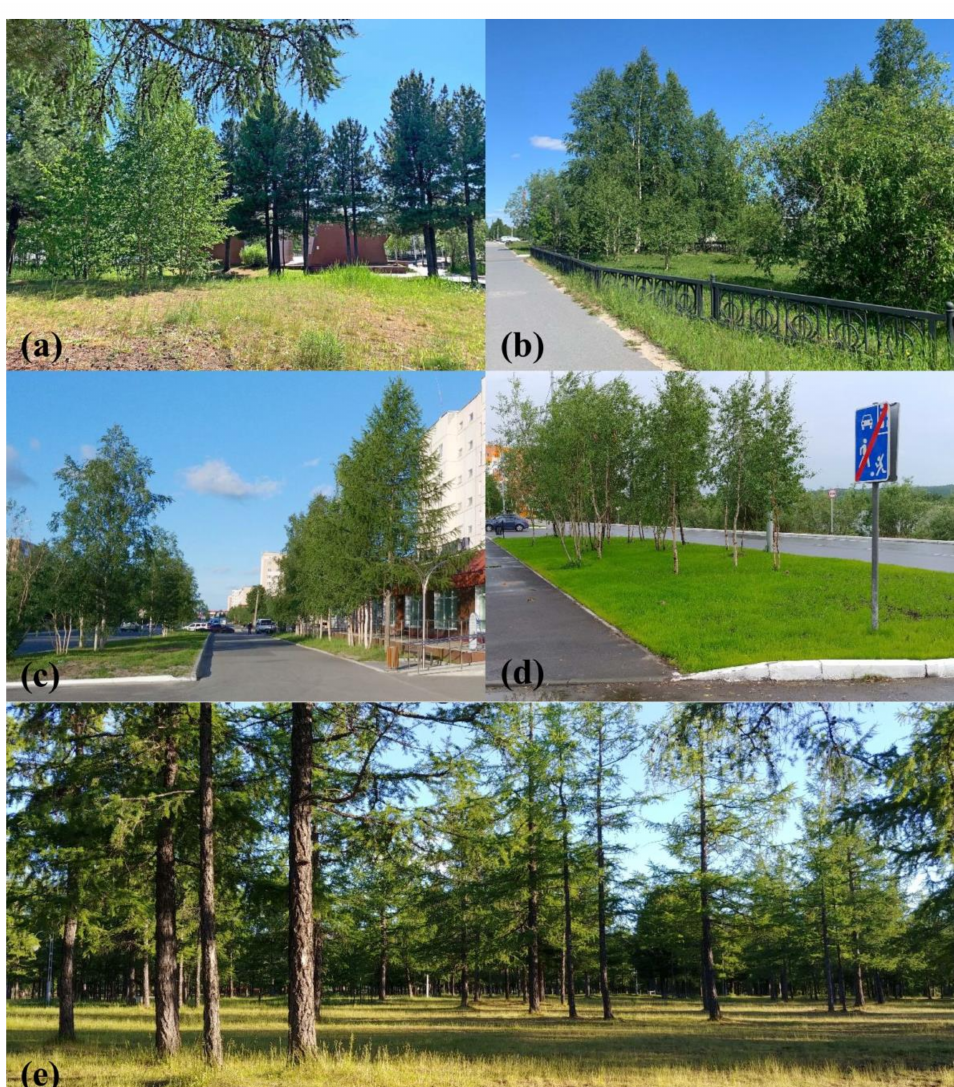
Figure 2. Trees in the city: ( a ) Square of Eternal Flame; ( b ) Tree alley on Yamalskaya street; ( c ) Tree alley on Komsomolskaya street; ( d ) Boulevard on the embankment named after S.A. Orudzhev; ( e ) Kozlov’s park. Photo by Yulia Pechkina, July